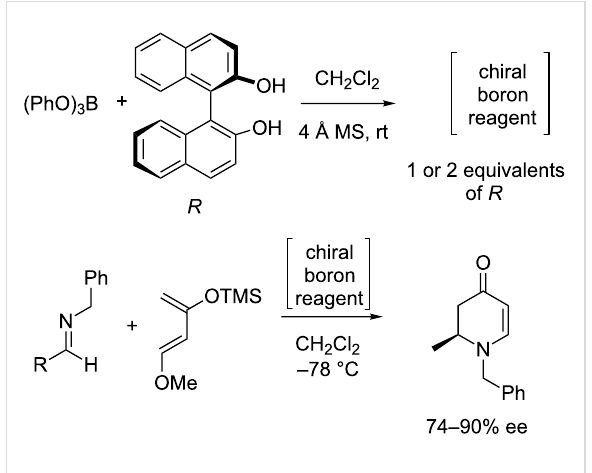
Figure 14: Preparation of chiral boron reagent and use as catalyst for aza-Diels–Alder reactions.